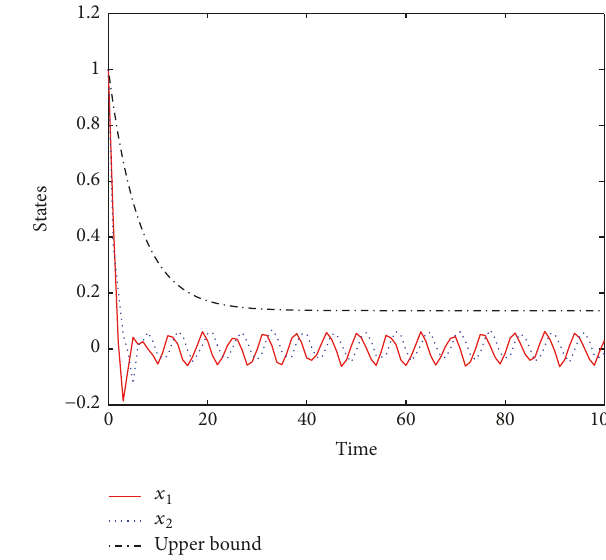
Figure 1: State and its upper bound of continuous-time system (1). Figure 2: State and its upper bound of discrete-time system